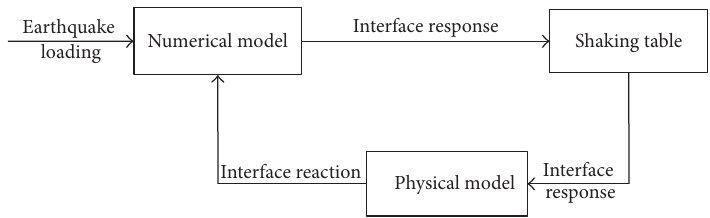
Figure 1: Generally schematic representation of RTDS using shaking